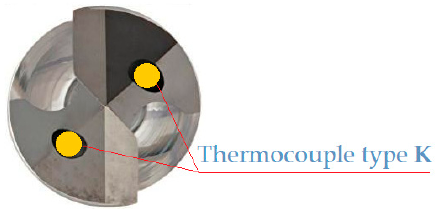
Figure 10. Drill with inserted thermocouples.